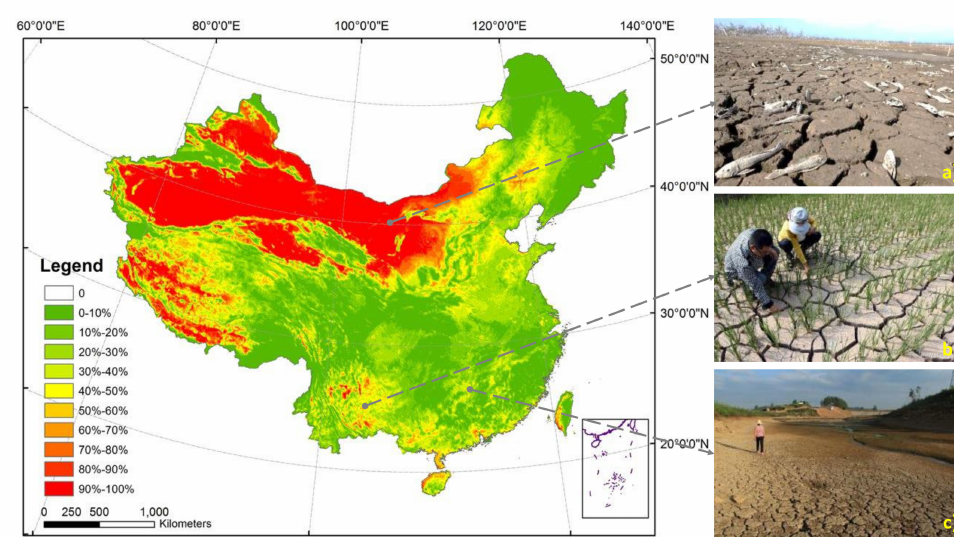
Figure 2. The central panel shows spatial distribution of drought frequency in China (after [44]. ( a ) Massive dead fish in a dried lake located in inner Mongolia ( credits: http: // earth-chronicles.com); ( b ) rice cultivated land, lack of soil moister and deep cracks in Xinqiao Township, southwest China’s Yunnan Province, July 8, 2015 ( credits: Xinhua / Yang Zongyou); and ( c ) Former Shima reservoir at Shima Village of Shaoyang County, central China’s Hunan Province, July 27, 2013, completely dried-up